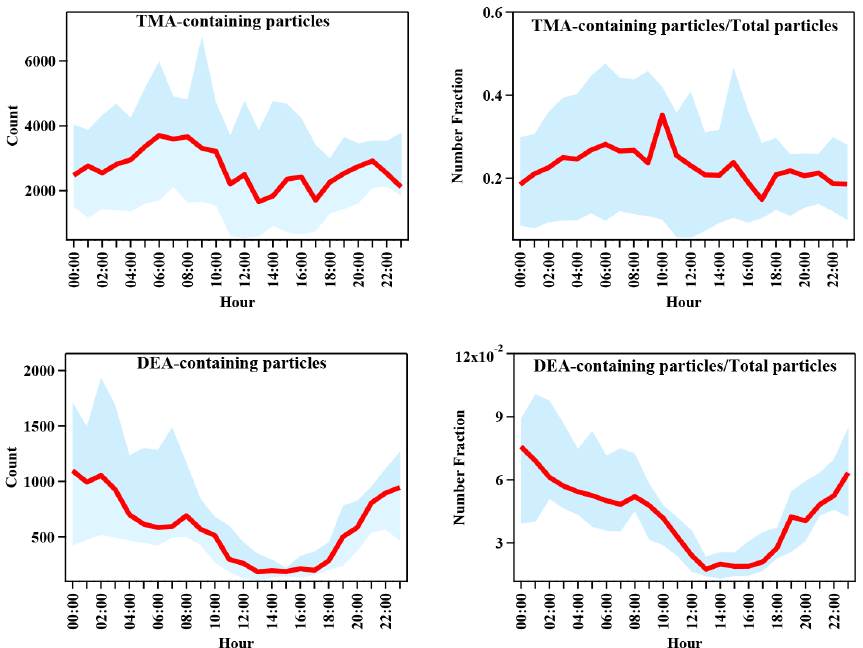
Figure 3. The diurnal variations in particle counts and number fractions of the two amine-containing particles in total particles during the entire sampling